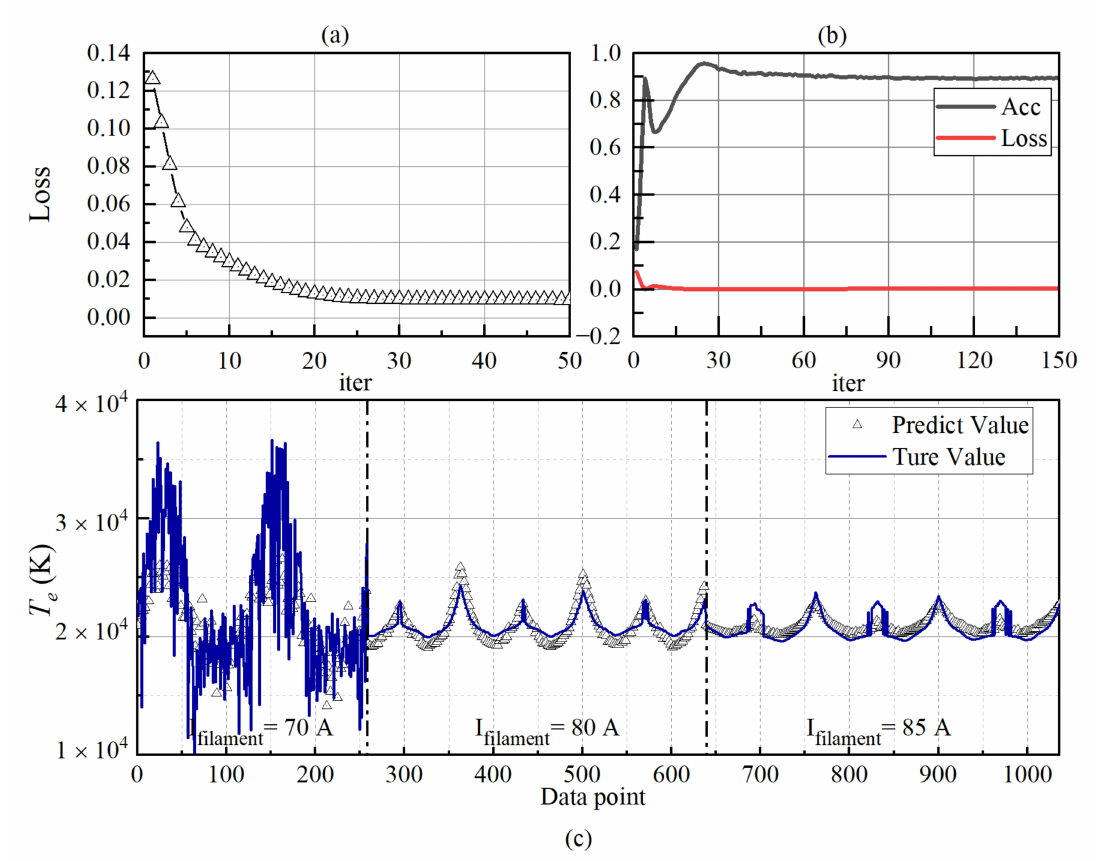
Figure 10. The training and prediction results of the T e . ( a ) The loss rate of the training set data; ( b ) The accuracy and loss rate of the verification set data; ( c ) Comparison of prediction